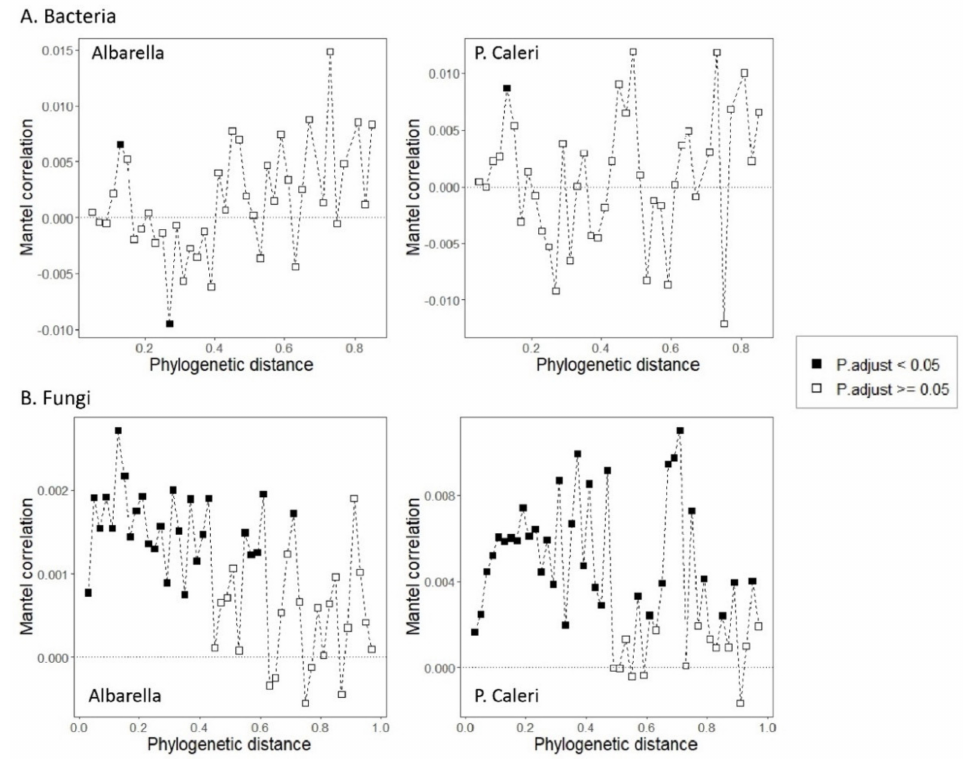
Figure 6. Phylogenetic Mantel correlogram showing significant phylogenetic signal across phy- logenetic distances. Solid and open symbols denote significant and nonsignificant correlations, respectively, relating betwen-OTU niche differences to between-OTU phylogenetic distances, across a given phylogenetic